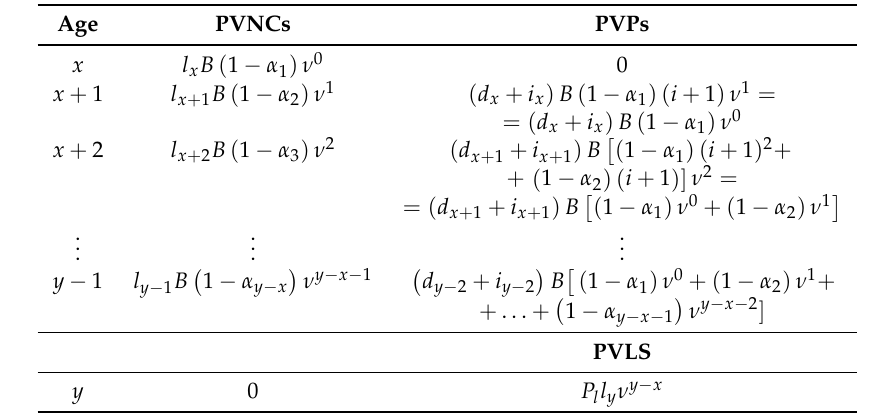
Table 2. Present values of individual net contributions and payments to the inheritors by period (except the last line). The last line consists of the present value of the lump sum